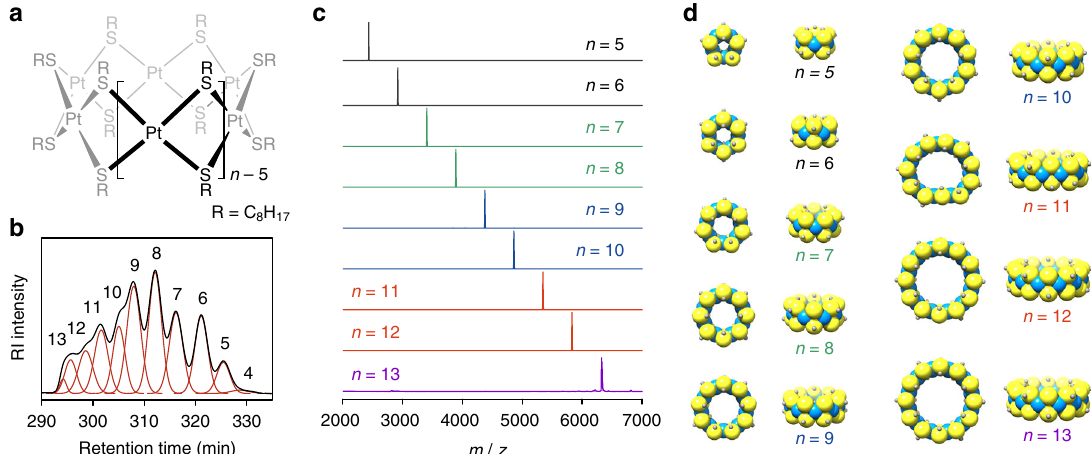
Fig. 1 Tiara-like platinum octanethiolate complexes [Pt( µ -SC 8 H 17 ) 2 ] n . a Chemical structure of the complexes. b Chromatogram of the preparative HPLC separation with size-exclusion columns ( SEC ) monitored by a refractive index detector. This chromatogram was recorded at fi ve cycles of the recycling processes. c MALDI-TOF-mass spectra of the isolated [Pt( µ -SC 8 H 17 ) 2 ] n ( n = 5 – 13) measured with DCTB matrix. d Optimized geometric structures at the B3LYP/LanL2DZ level. Platinum, sulphur, and α -carbon atoms are shown as blue , yellow , and gray spheres , respectively. The hydrogen atoms are omitted for